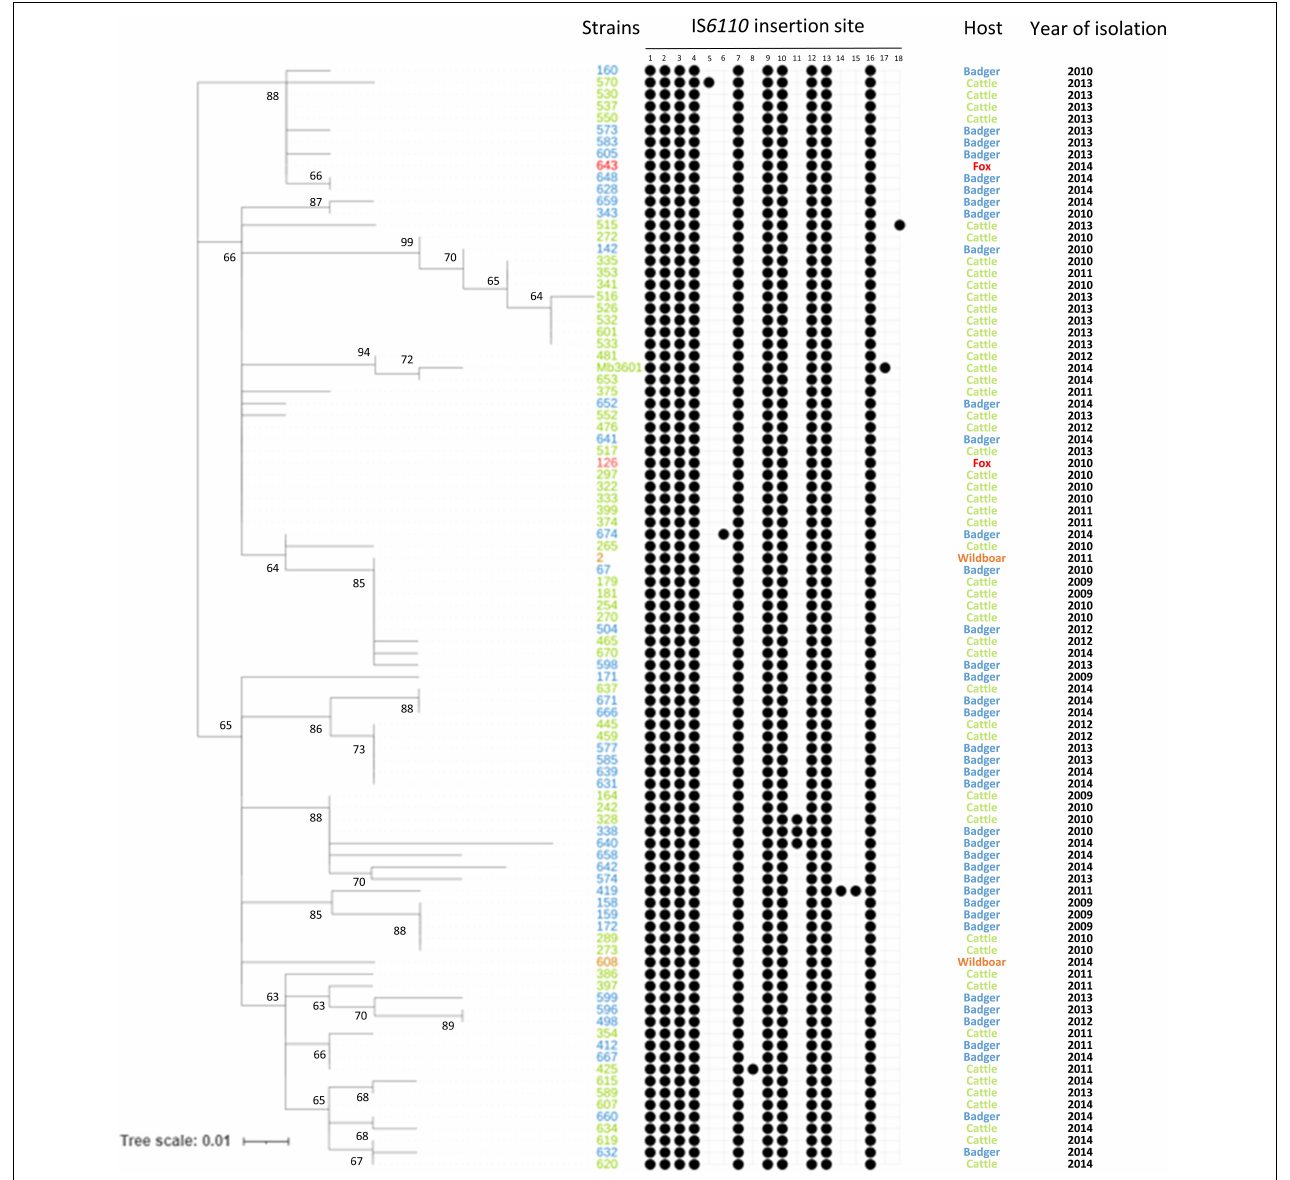
FIGURE 2 | IS 6110 in M. bovis SB0120-CO over time and between different host species. Heatmap showing the presence or absence of IS 6110 in 93 sympatric SB0120-CO genomes. Black spots show the presence of IS 6110 in a specific site. Nucleotide positions of each IS 6110 site are described in Supplementary Table 3 . The tree is based on 124 whole-genome single nucleotide